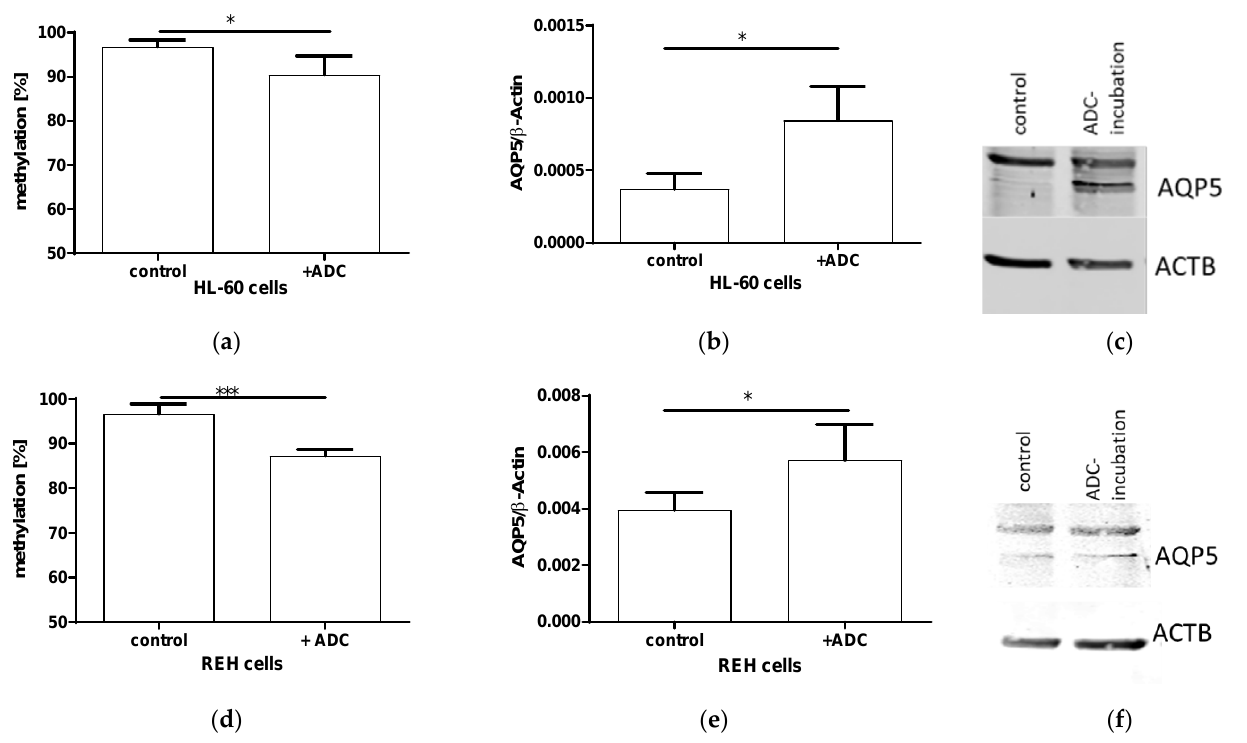
Figure 3. Incubation of proliferating immune cells HL-60 and REH with 50 µM aza-deoxycytosin (ADC) for 72 h. The AQP5 promoter methylation in the promoter region nt-145 to nt-49 in HL-60 ( a , n = 4) and REH cells ( d , n = 4) decreased after ADC incubation. The AQP5 mRNA expression increased in HL-60 ( b , n = 4) and REH cells ( e , n = 4). A similar effect could be detected in the protein expression in HL-60 ( c ) and REH ( f ) cells, where a representative bot out of three experiments is shown (* p ≤ 0.05; ** p ≤ 0.01; *** p ≤ 0.001) .